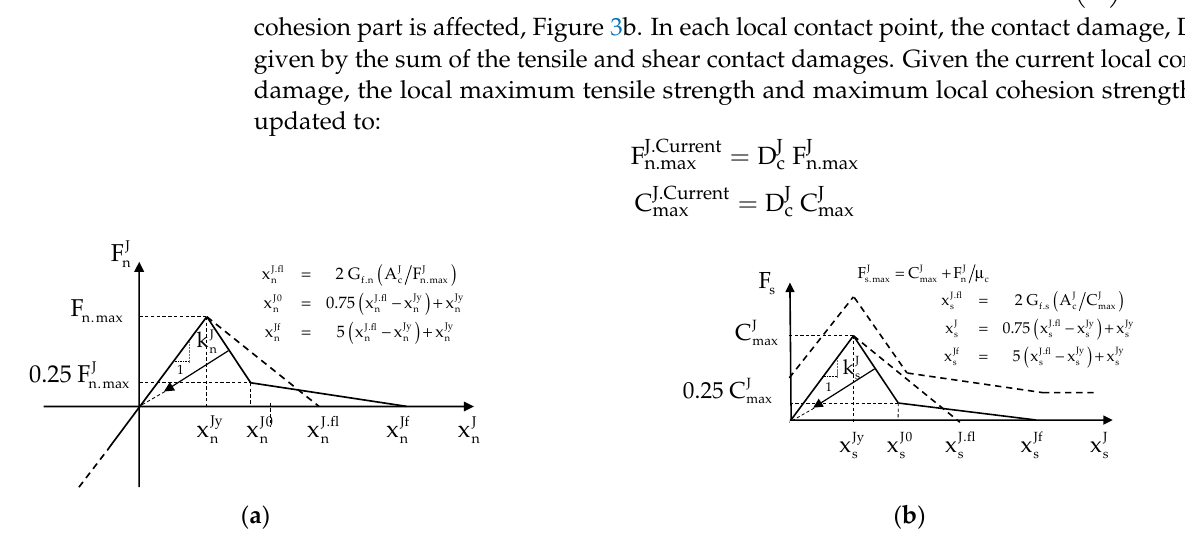
performed, Figure 4c. As previously mentioned, in the proposed flexible PM model, the contacts are adopted following the contact geometry of the Voronoi